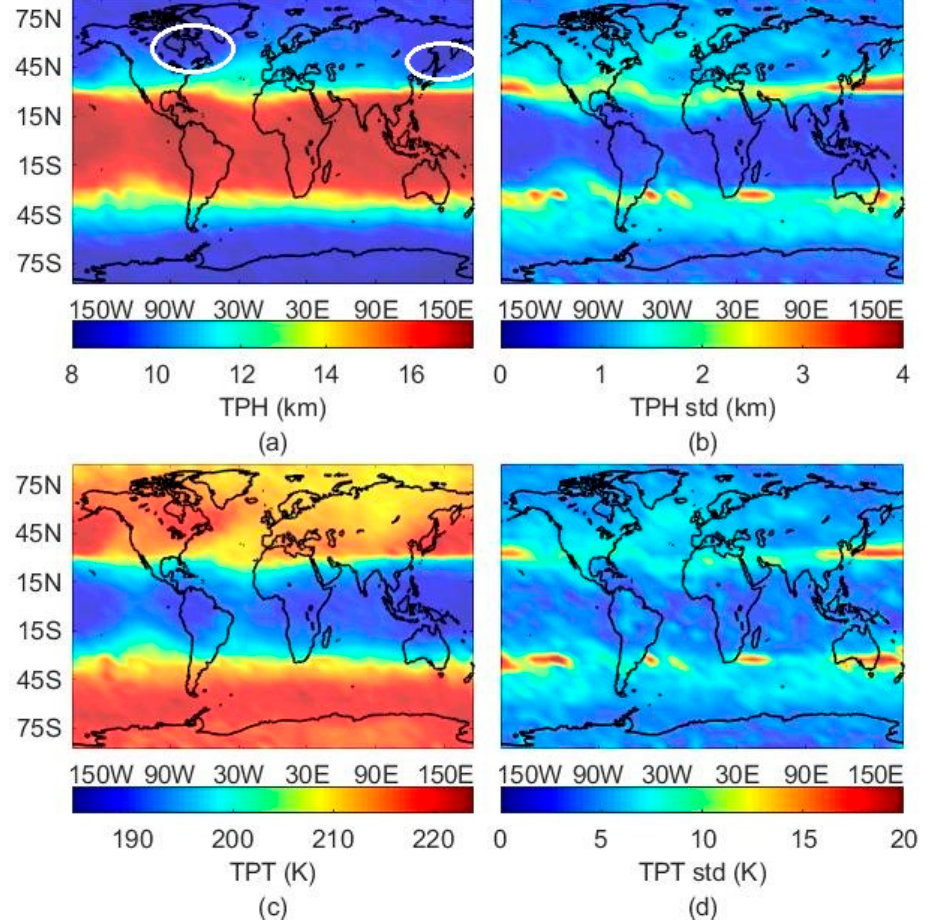
Figure 13. Seasonal patterns ( a – d ) of TPT and TPH for winter (December, January, February). Two white circles identify two areas where the tropopause is obviously low.